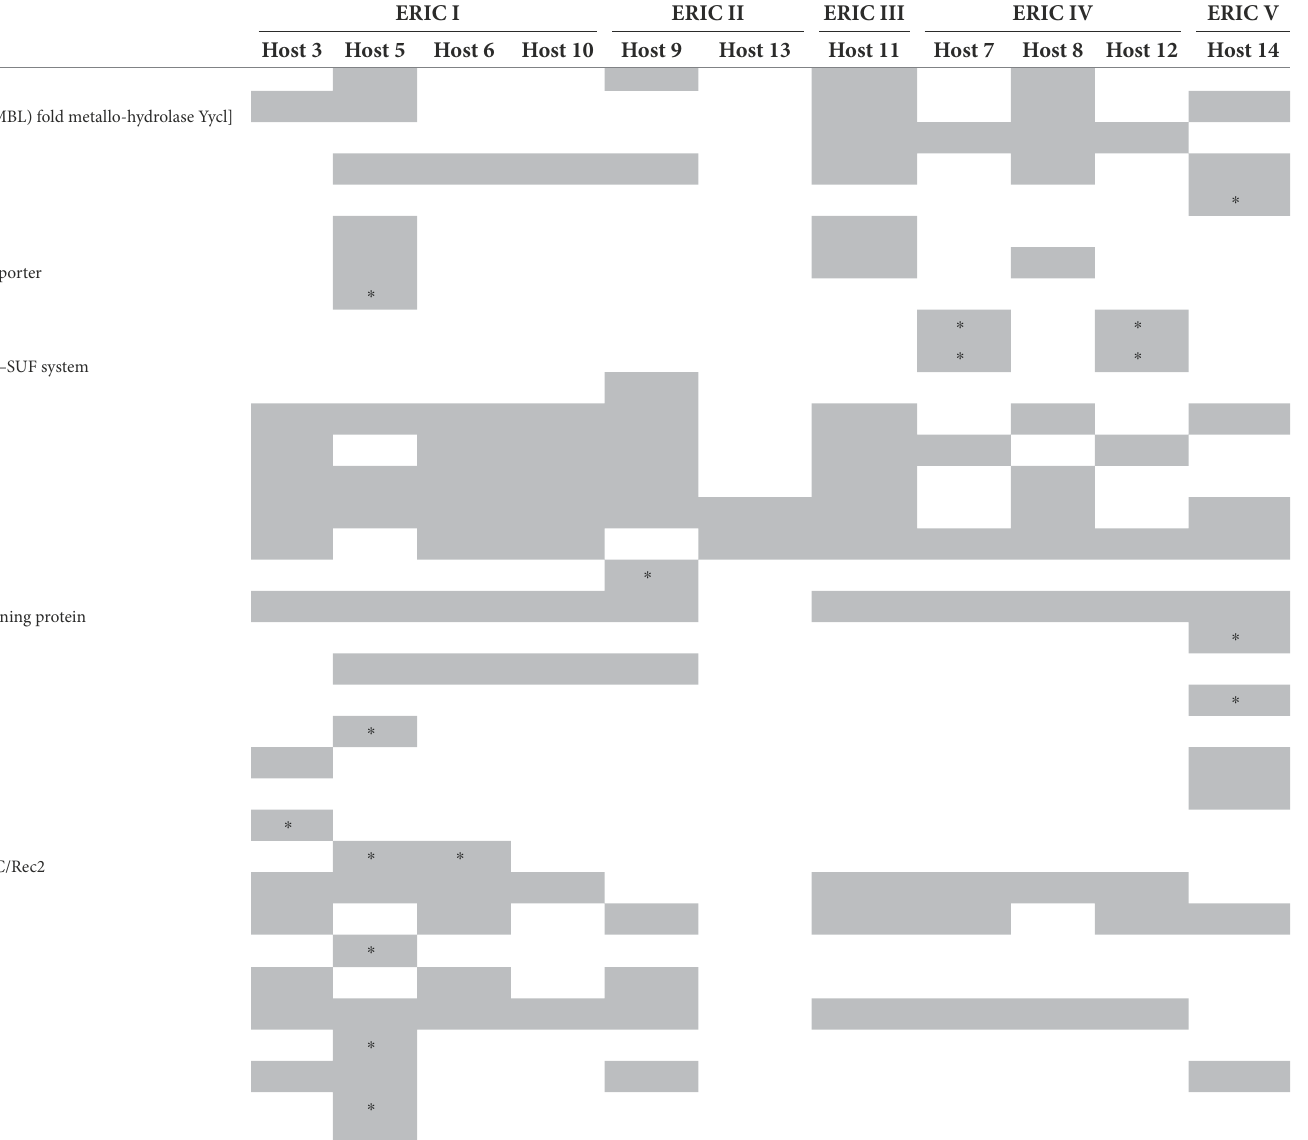
TABLE 2 Coding DNA sequences (CDS) identified in prophages potentially influencing host virulence or